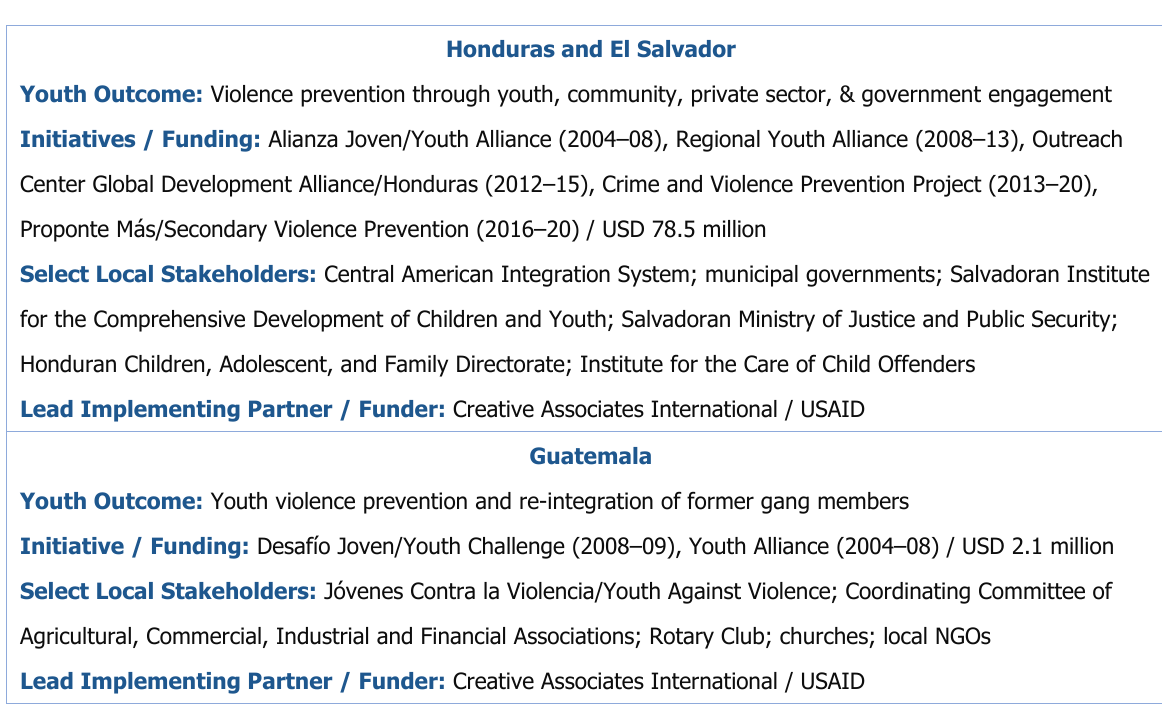
Table 1. Summary of Featured Youth Systems Case Studies by